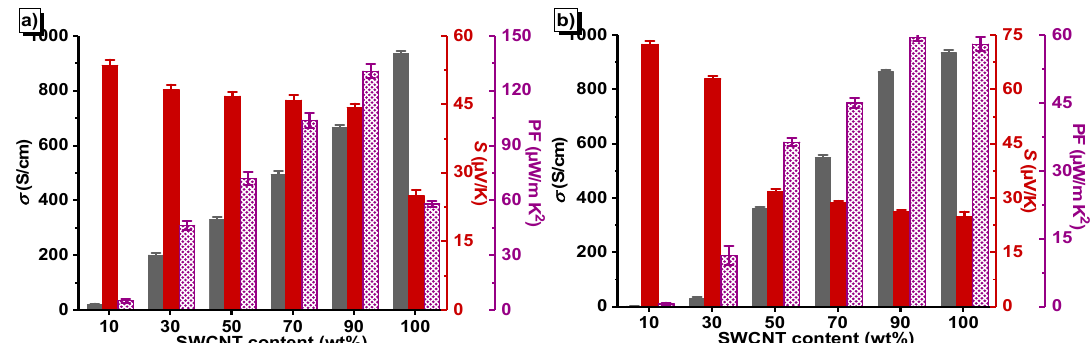
Figure 2. The histogram of σ , S and PF of ( a ) P(TBT-Pt) and ( b ) P(TBT) versus different SWCNT loading. Table 1. Thermoelectric (TE) parameters of P(TBT-Pt) and P(TBT) hybrid films at room temperature. SWCNT (wt%) (a)